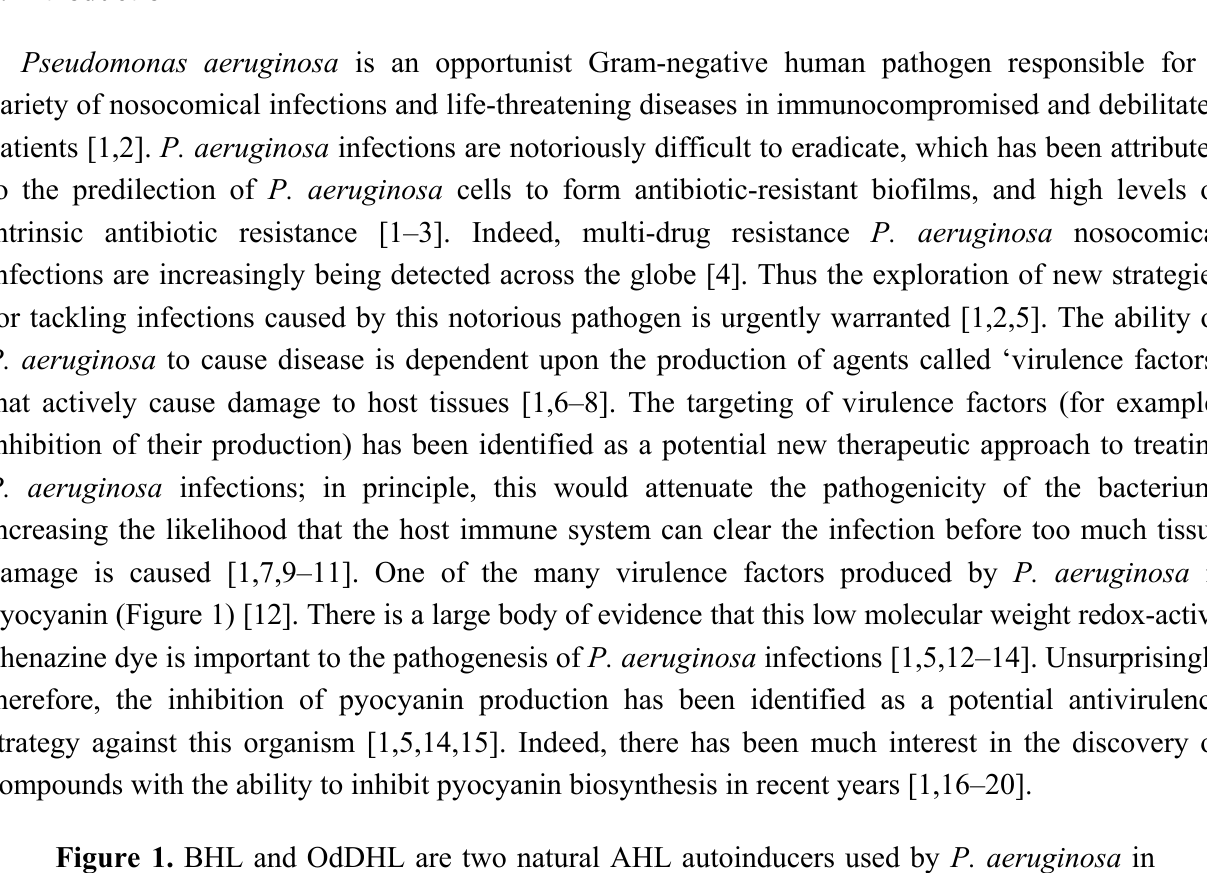
Figure 1. BHL and OdDHL are two natural AHL autoinducers used by P. aeruginosa in quorum sensing. Pyocyanin is a virulence factor produced by P. aeruginosa . Compound 1 , an abiotic OdDHL-mimic, is capable of strongly inhibiting the production of pyocyanin in cultures of wild type P. aeruginosa